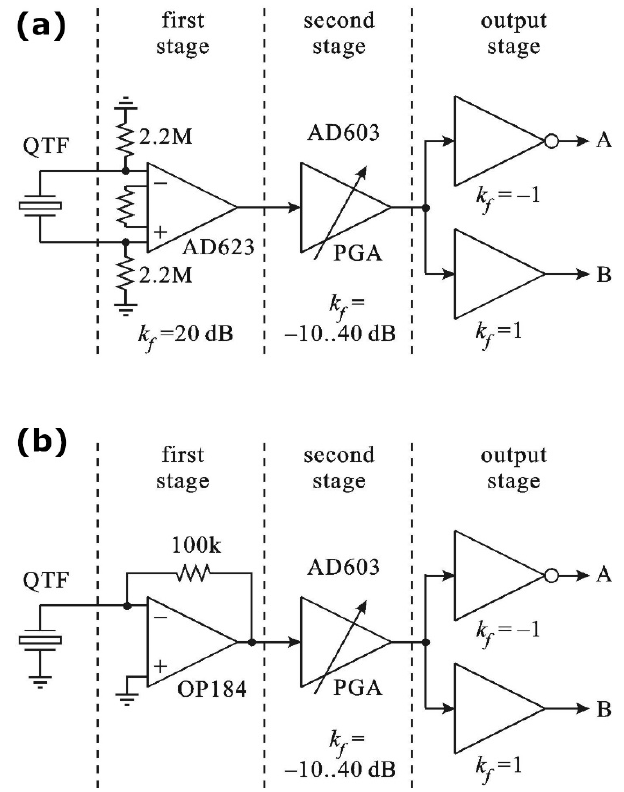
Figure 2. Simplified circuit diagrams of the tested QTF signal amplifiers with: ( a ) voltage amplifier input, ( b ) transimpedance amplifier input.